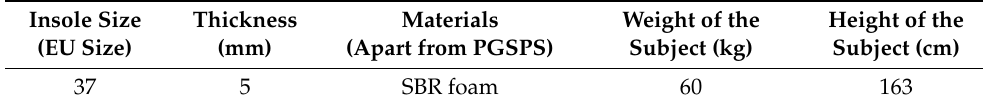
Table 3. The characters of the insole and the subject condition.